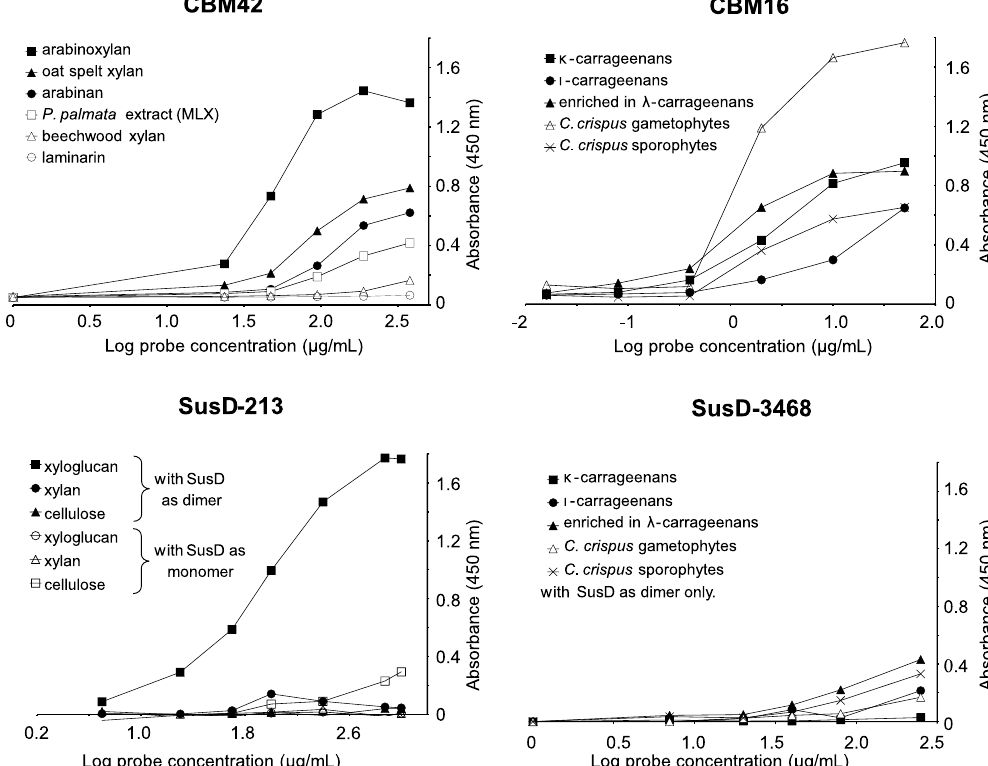
Figure 5. Biochemical validation of the binding abilities of the purified probes by microtiter plate assays. Binding of CBM42, CBM16(2), SusD-213 and SusD-3468 in capture microtiter plate assays with a selection of purified polysaccharides and cell wall extracts as immobilized